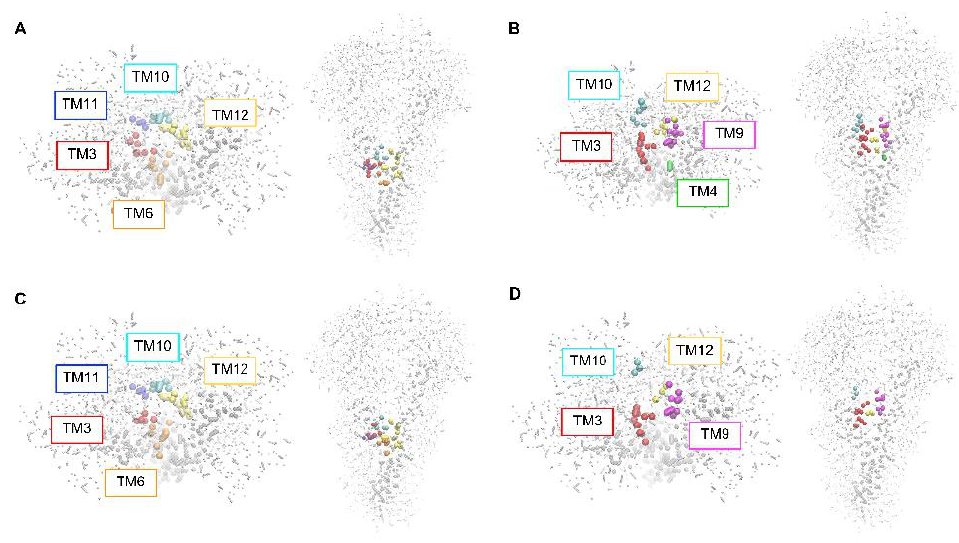
Figure 8. P–gp residues that interacted with the NBD–Cn molecules during the 0.0 nm umbrella window simulation, for NBD–C4 ( A ), NBD–C8 ( B ), NBD-C12, ( C ) and NBD–C16 ( D ). P–gp is shown in gray, with the TM4/6 gate in a darker shade. Residues from TM3 are highlighted in red, from TM4 in green, TM6 in orange, TM9 in pink, TM10 in light blue, TM11 in dark blue, and TM12 in yellow. In each panel, the protein is shown both in the upper view from NB–domains ( left ) and in the front view ( right ).